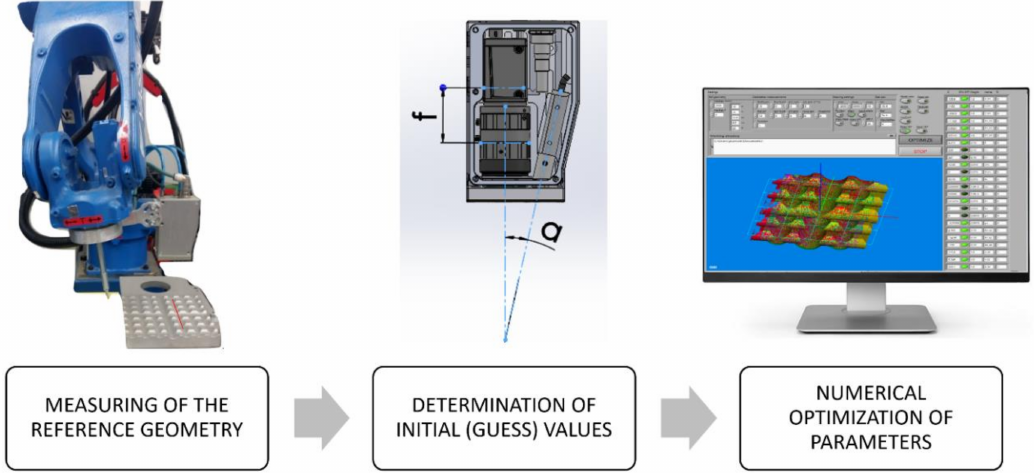
Figure 3. Basic steps of the calibration